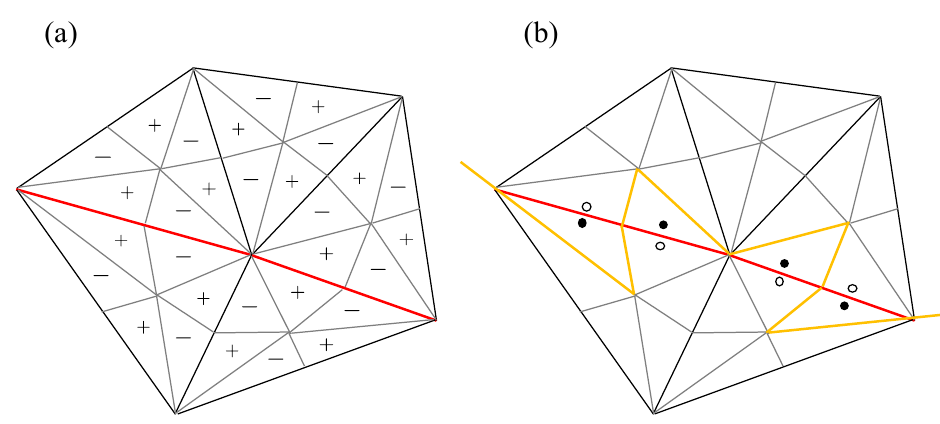
Figure 2 . (a): the signs of d -simplices near the orientation reversing wall, which is represented as a red line. (b): assignment of Grassmann variables on the wall speci(cid:12)es a deformation of the wall that intersects the wall transversally at ( d (cid:0)